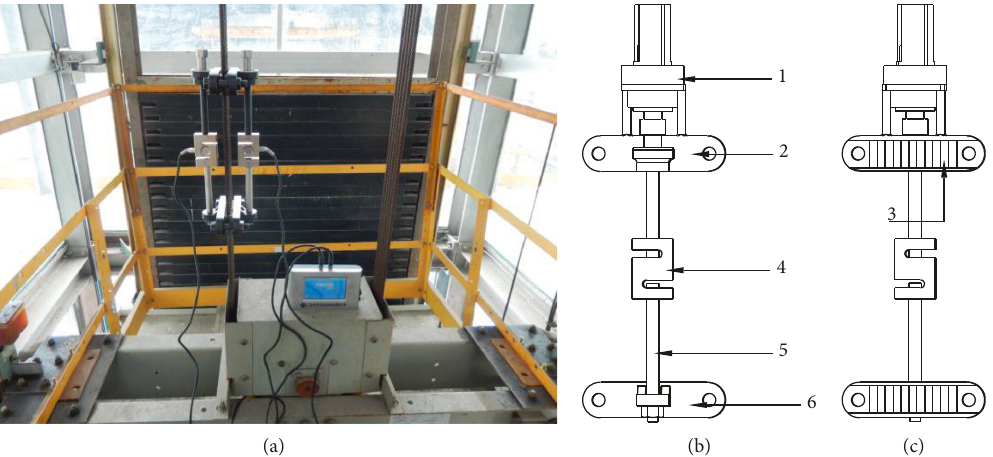
Figure 4: Quality test picture of elevator car. (1) Servomotor, (2) C1, (3) lining block, (4) tension sensor, (5) connecting screw, and (6) C2. (a) Assembly diagram. (b) Unilateral front view. (c) Unilateral back view.